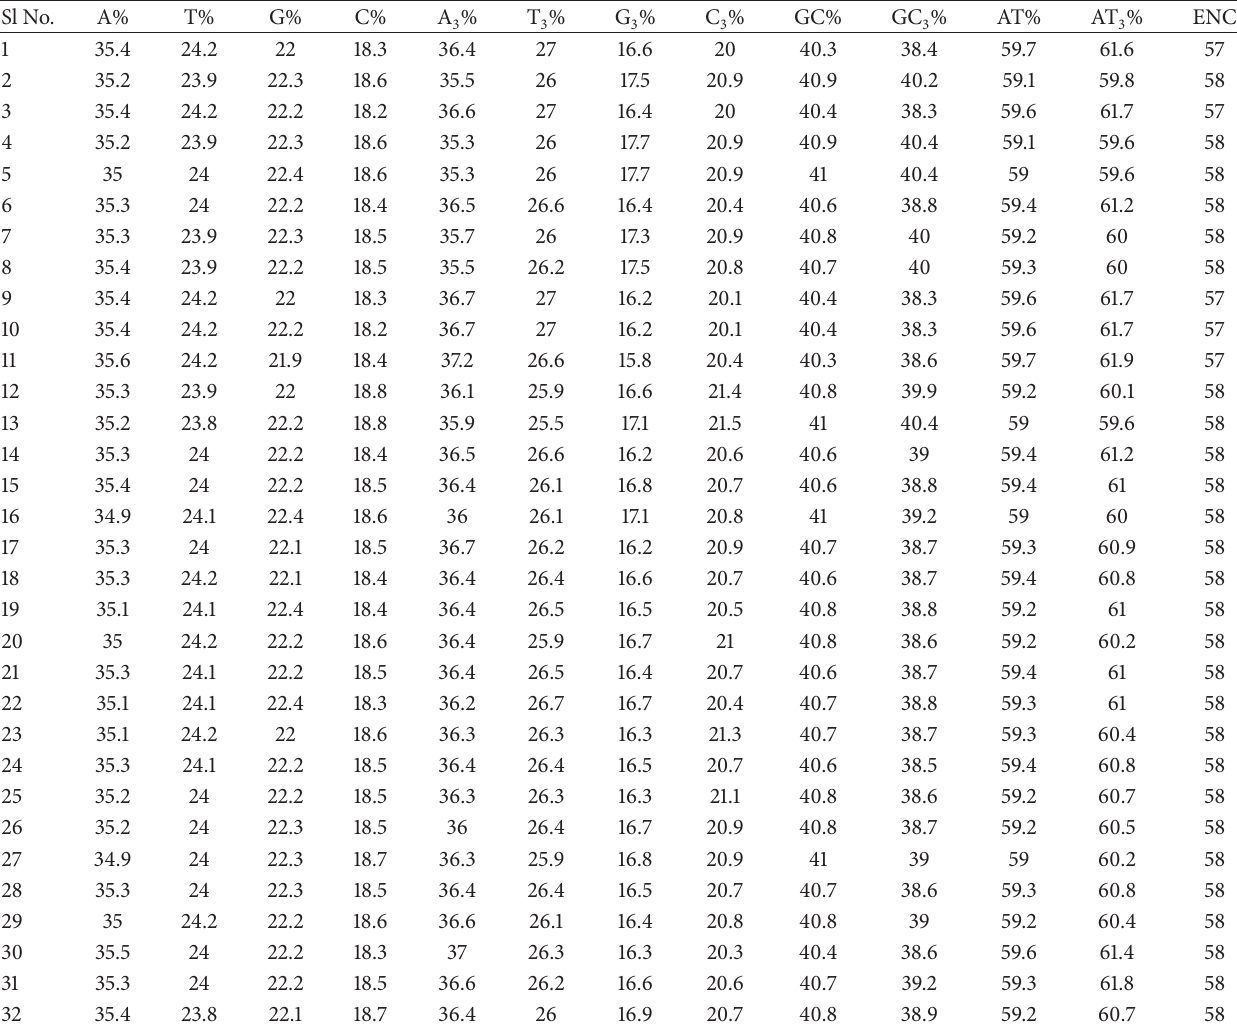
Table 1: Nucleotide composition of the genes used in the